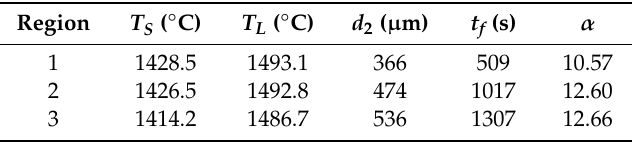
Table 3. Calculated parameters for the investigated regions.